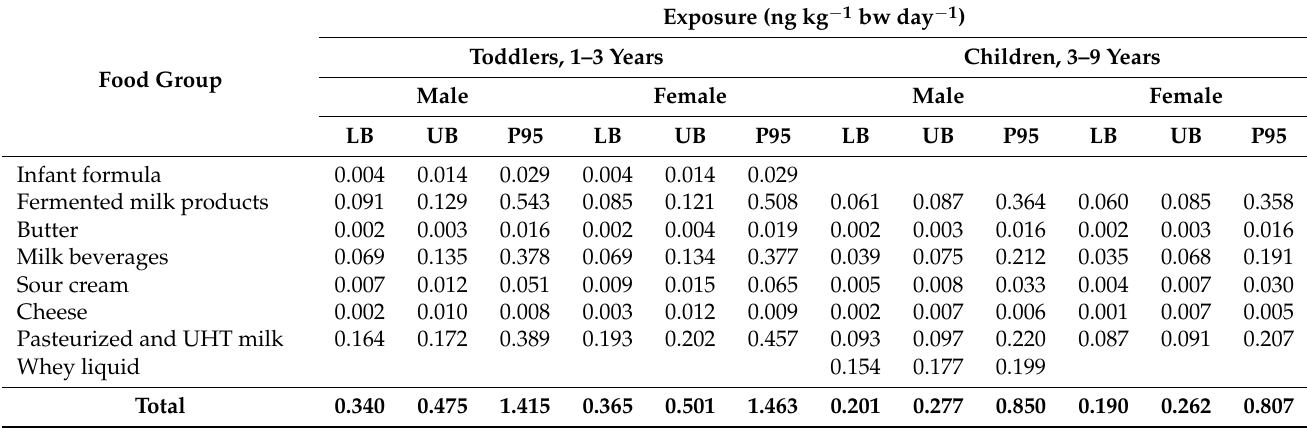
Table 4. Estimated daily intake (ng kg − 1 bw day − 1 ) of AFM1 in selected food products for two age categories.